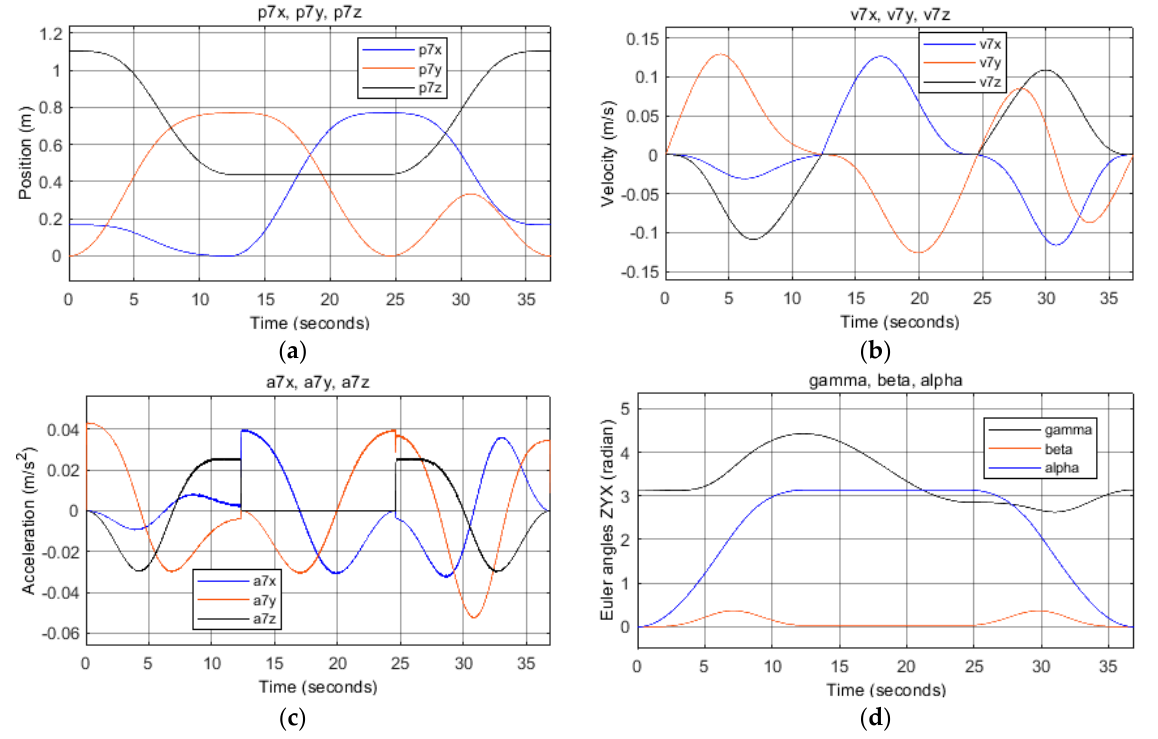
Figure 10. Effector values measured in Matlab: ( a ) position vector p 7 = [ p 7x , p 7y , p 7z ] T depending on the joint coordinate vector φ (t) ; ( b ) velocity vector v 7 = [ v 7x , v 7y , v 7z ] T depending on the joint coordinate vector φ ′ (t) ; ( c ) acceleration vector a 7 = [ a 7 x , a 7 y , a 7 z ] T depending on the joint coordinate vector φ ″ (t) and ( φ ′ (t) ) 2 ; ( d ) Euler’s angles ( γ , β , α ) depending on the joint coordinate vector φ (t).